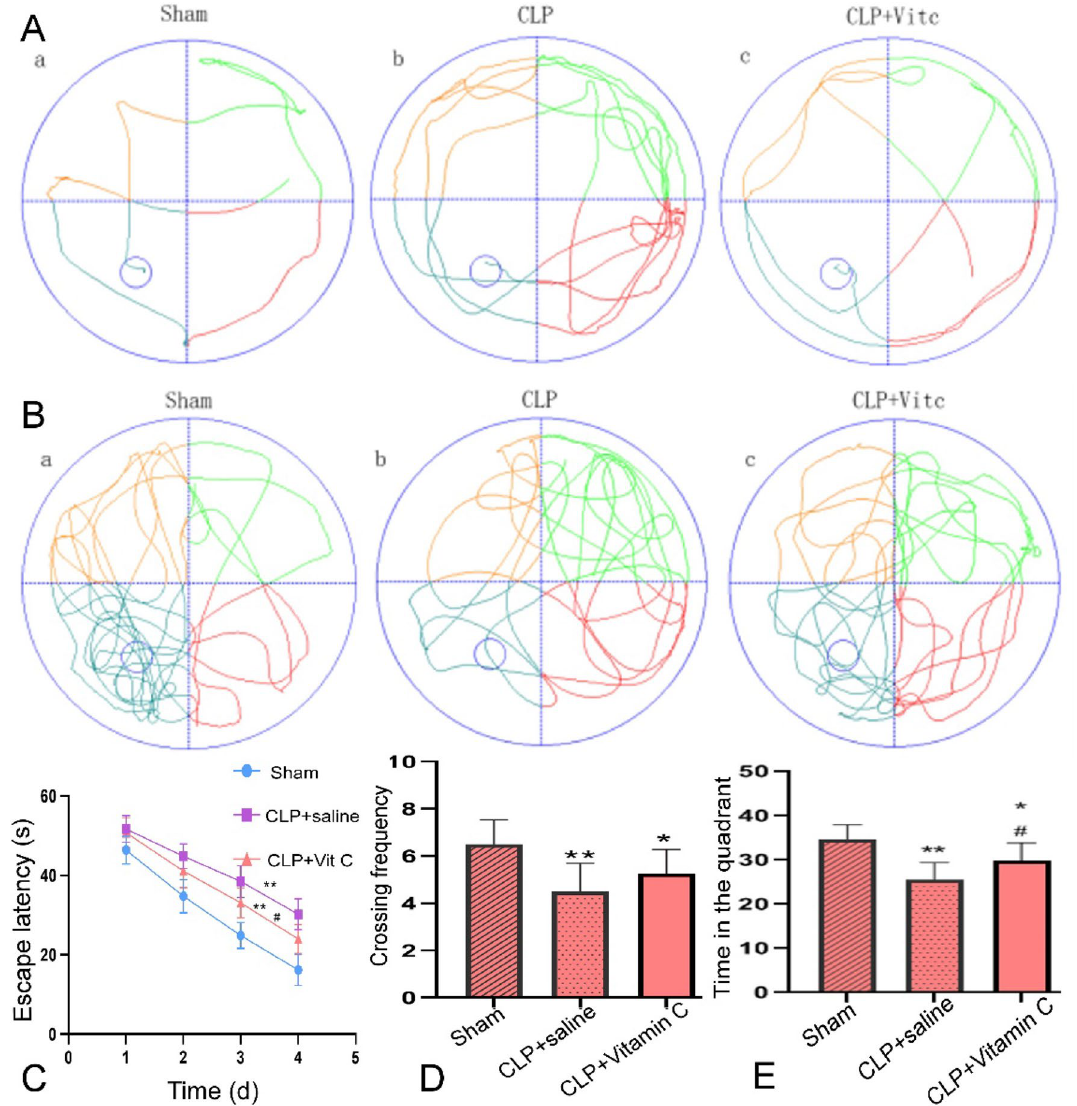
Figure 1. The performance of rats in three groups in the Morris water maze test. ( A ) Typical behavioral traces of three groups rats in the place navigation test. The more lines in the quadrants, the longer the escape latency. The rats in the CLP sepsis model group had significantly (P = 0.001) longer escape latency compared with the Sham and CLP + vitamin C groups. ( B ) Typical behavioral traces of the rats in three groups in the spatial probe test. The denser the blue lines in the quadrant where the platform is, the longer the retention time of rats. The rat retention time was significantly (P = 0.001) elongated in the platform quadrant in the Sham and CLP + vitamin C group compared with the CLP sepsis model group. ( C ) Comparison of the escape latency of the rats in three groups. The escape latency was significantly (P = 0.003) improved in the CLP + vitamin C group compared with the CLP model group. D&E. Comparison of the crossing frequency ( D ) and time ( E ) spent in the target quadrant of the rats in three groups, with significant improvement in the CLP + vitamin C group compared with CLP group. * P < 0.05 and ** P < 0.01 compared with sham group; # P < 0.05 compared with CLP + saline group. CLP cecal ligation and puncture, Vit C vitamin